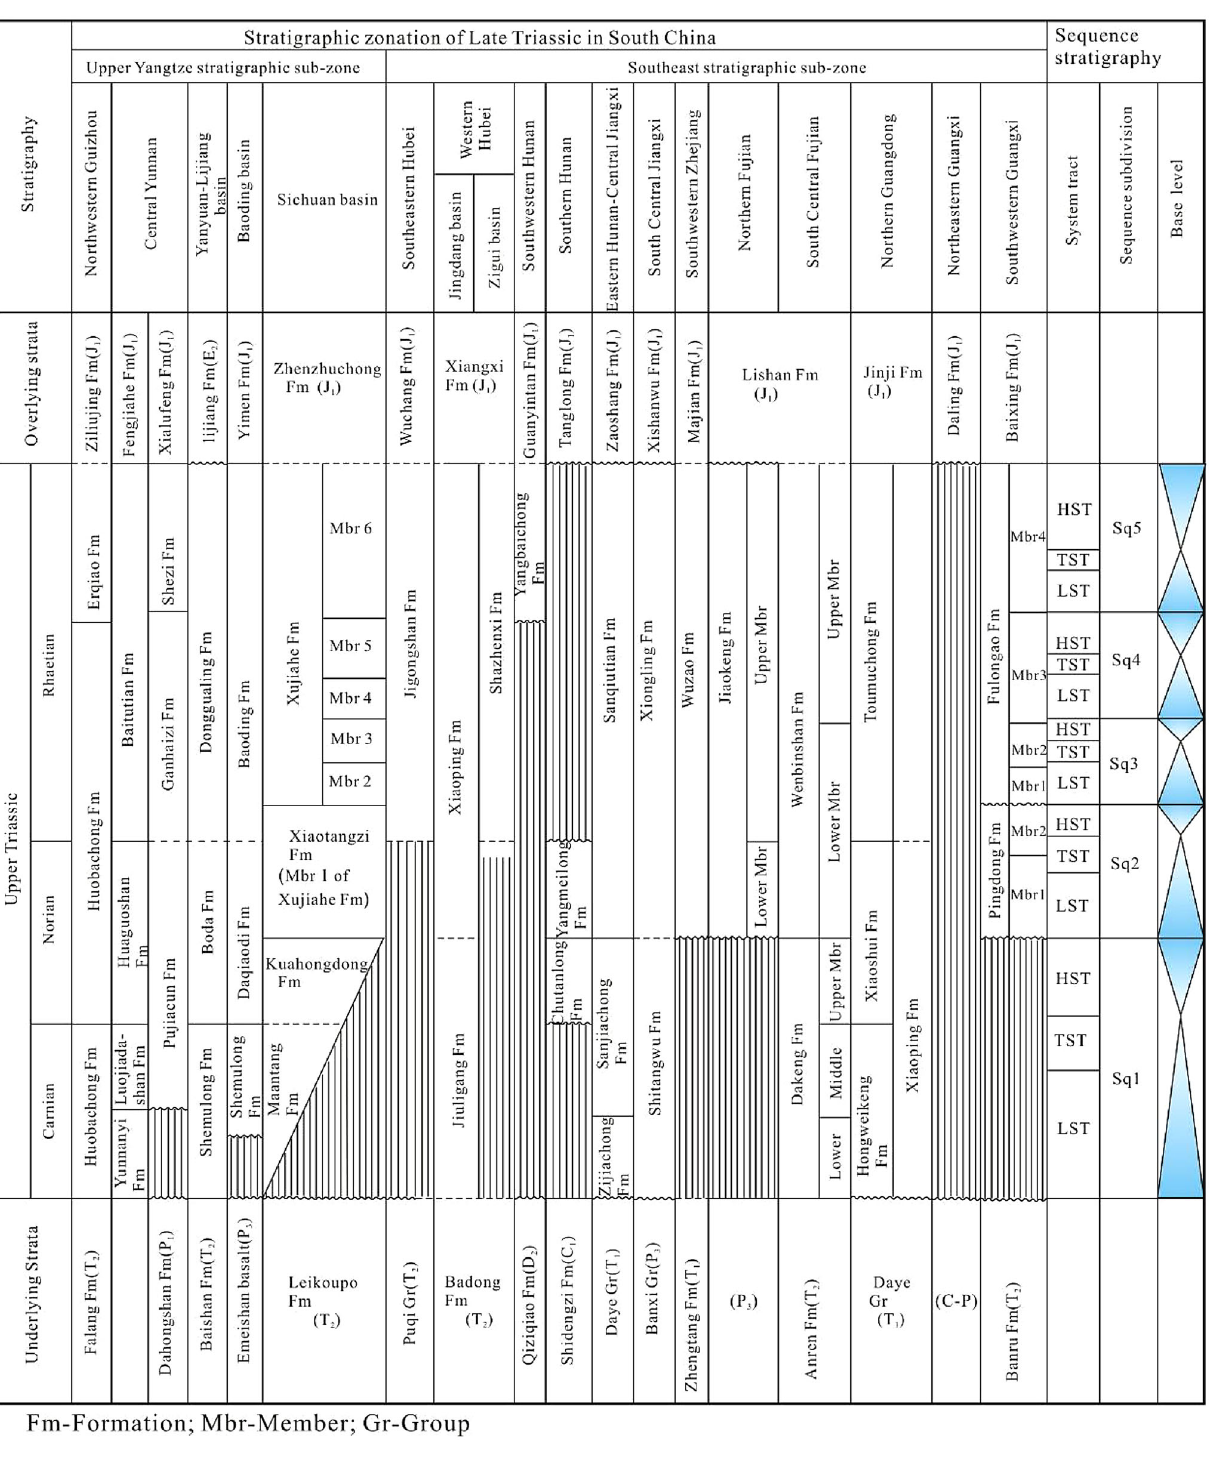
Fig. 10 Lithostratigraphy and sequence stratigraphic framework of the Late Triassic coal-bearing strata in the South China CAA (revised after Shao et al. 2014b)